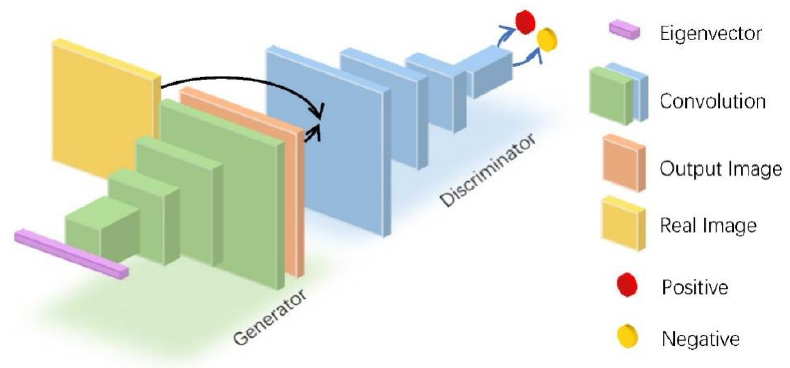
Figure 10. Typical structure of GAN of Image generated from eigenvectors.